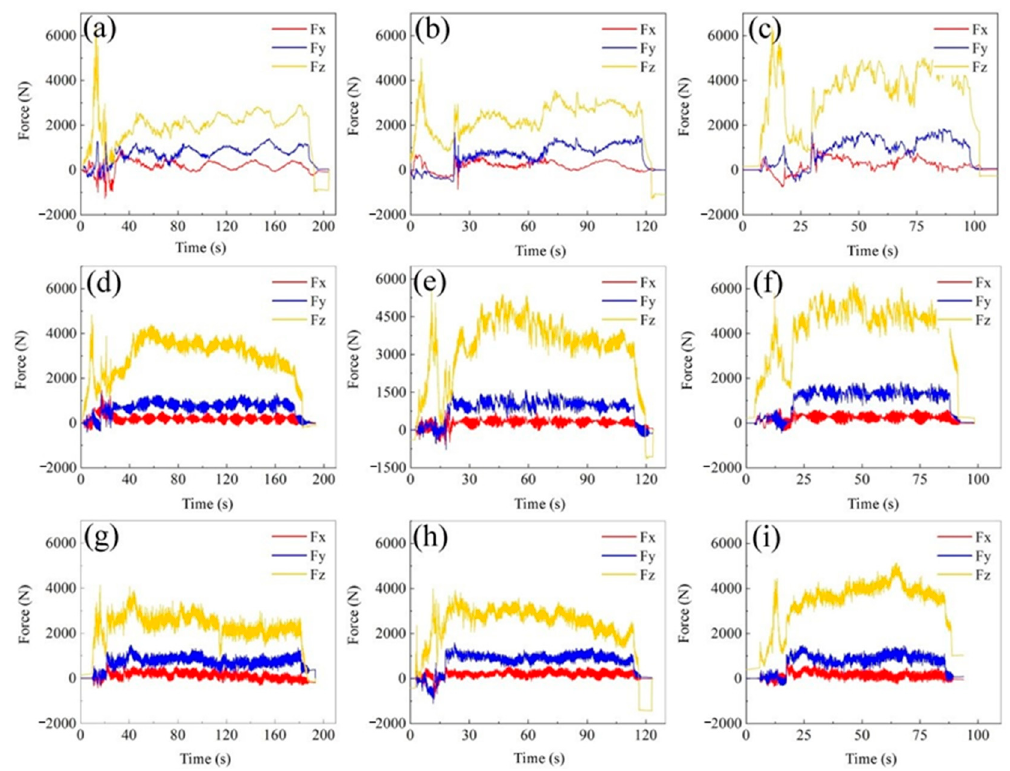
Figure 4. The three directional forces during the FSLW process stage. ( a ) 1000 rpm, 30 mm/min; ( b ) 1000 rpm, 50 mm/min; ( c ) 1000 rpm, 70 mm/min; ( d ) 1500 rpm, 30 mm/min; ( e ) 1500 rpm, 50 mm/min; ( f ) 1500 rpm, 70 mm/min; ( g ) 2000 rpm, 30 mm/min; ( h ) 2000 rpm, 50 mm/min; ( i ) 2000 rpm, 70 mm/min